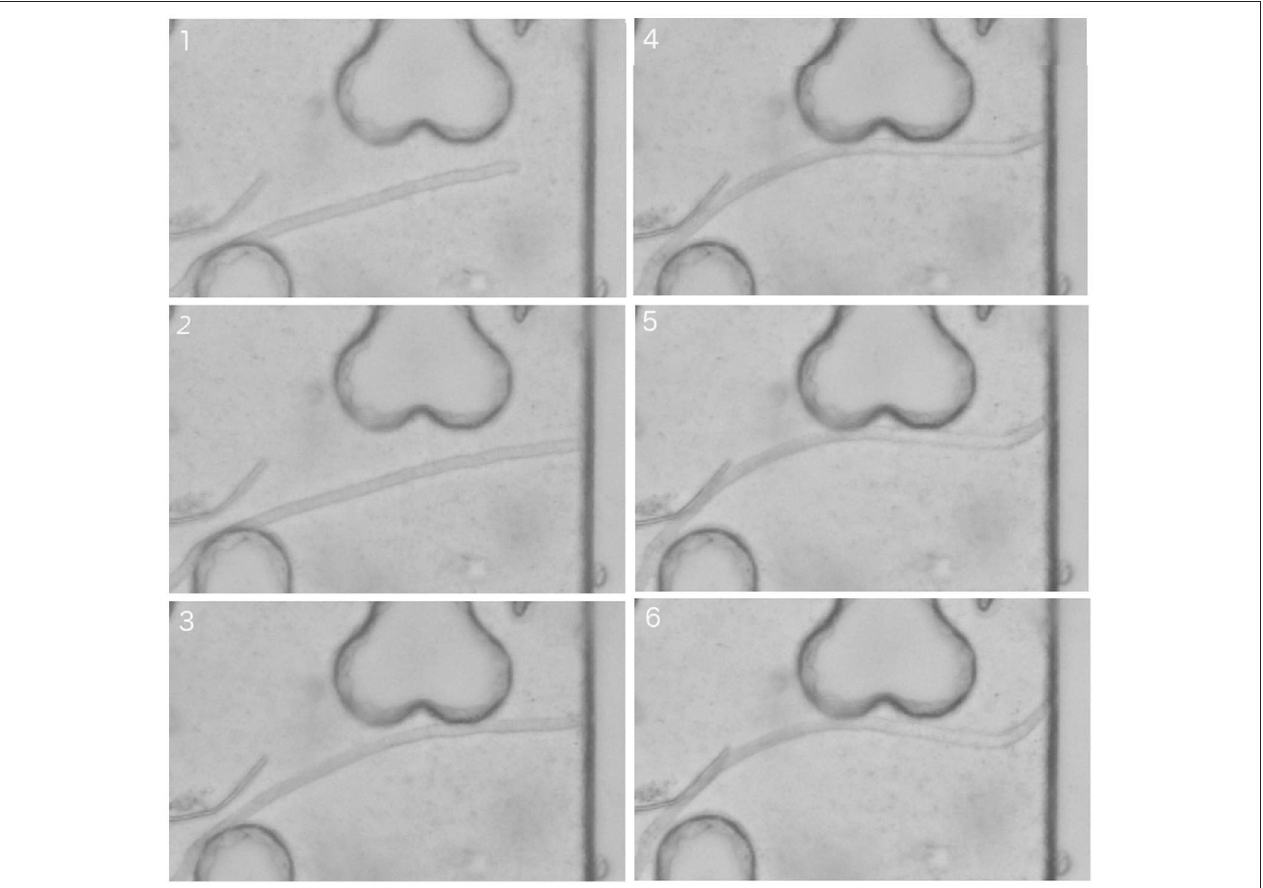
FIGURE 6 | Time sequence of 6 successive snapshots (1 to 6) of the propagation and bending of a hypha and its encounter “head on” with a pore wall.